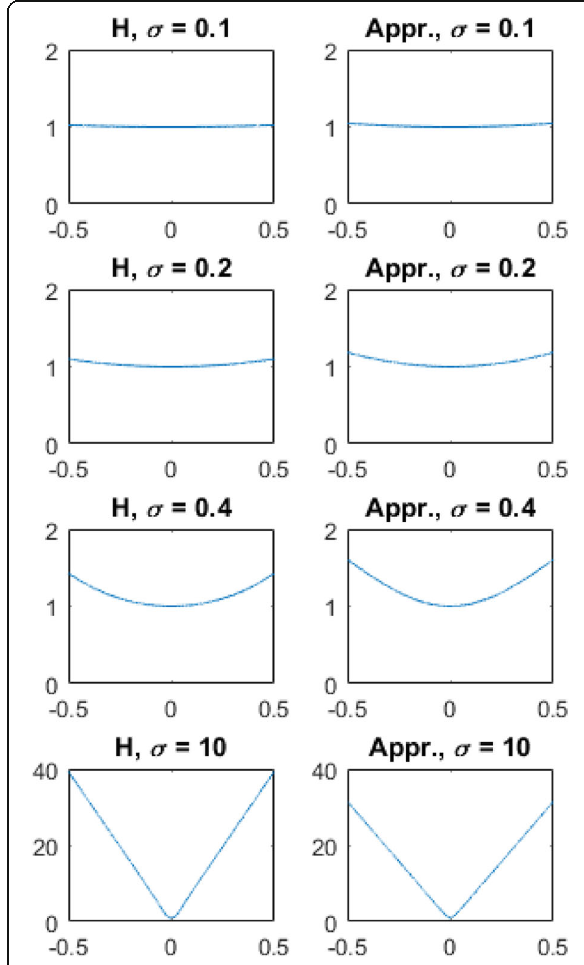
Fig. 5 Some examples of the tomographic filters for the time-of- flight backprojection filtering algorithm with different σ values. Left: Fourier domain transfer functions (Eq. 14). Right: Square-root function approximations (Eq.